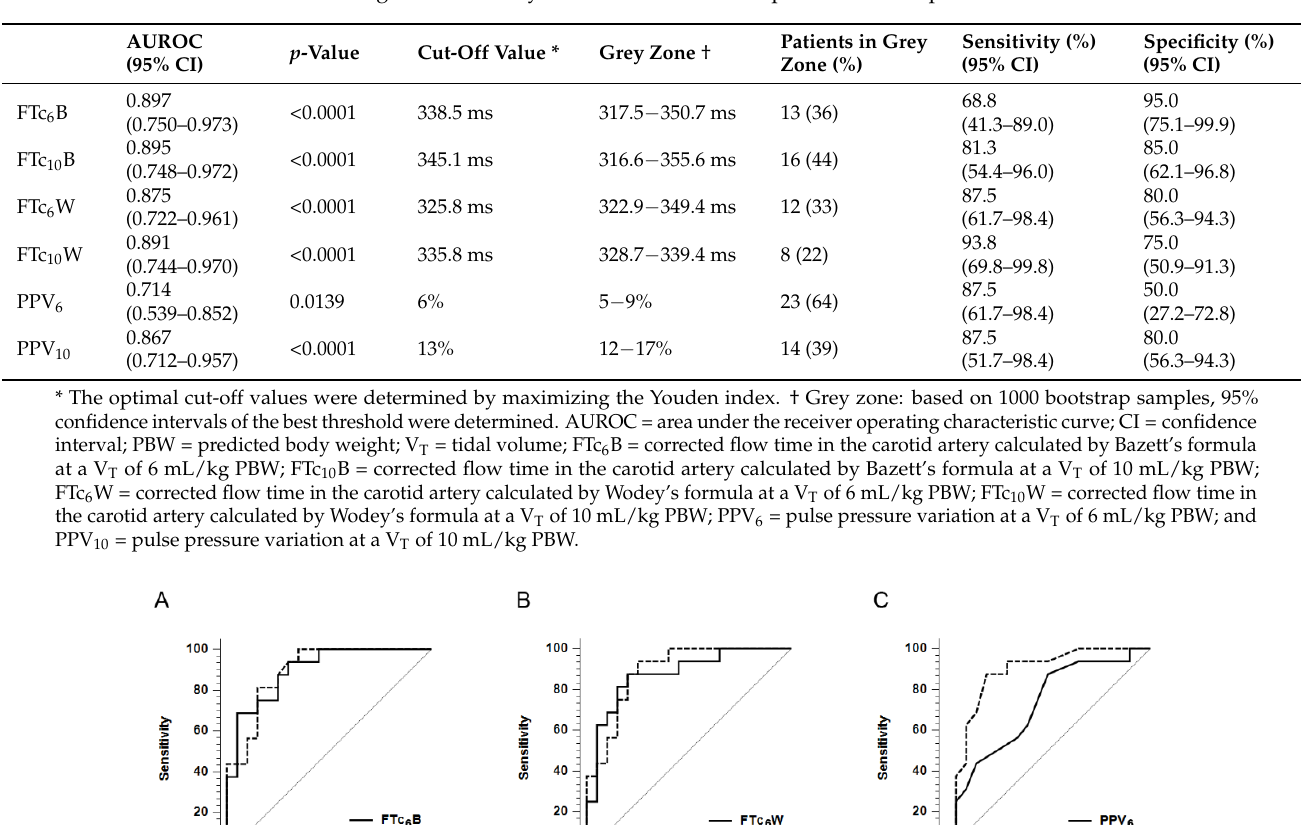
Table 3. Diagnostic accuracy of various variables to predict fluid responsiveness.